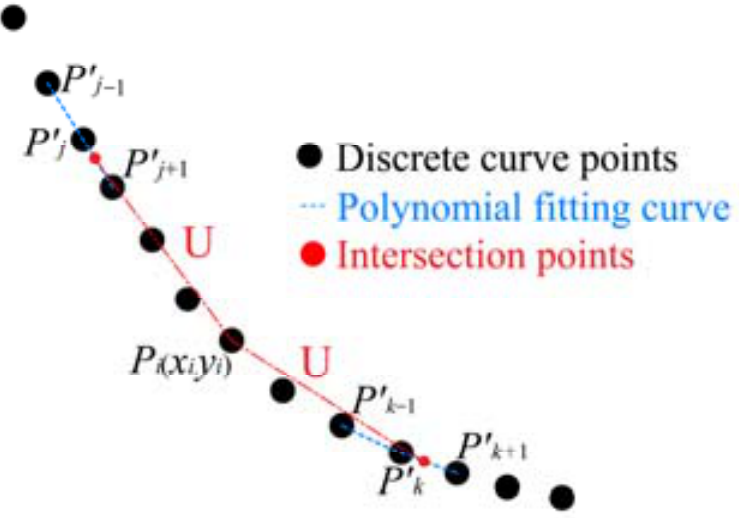
Figure 5. The supported domain of U-chord curvature.